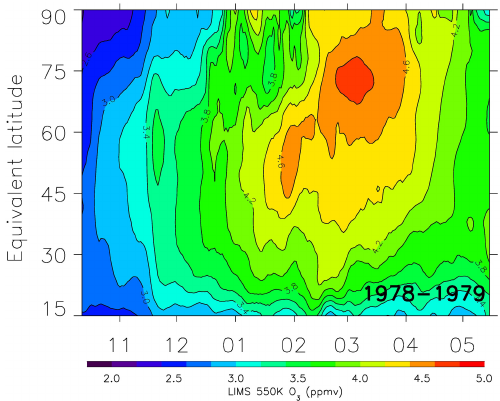
Figure 20. As in Fig. 17, but for HNO 3 at 450K (CI is 0.5ppbv).